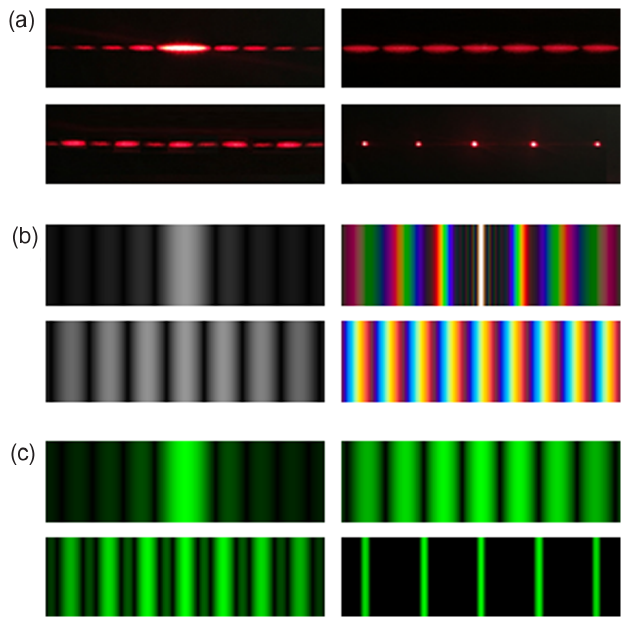
FIG. 1. (a) Red laser light patterns obtained by the single slit, double slit, three slits, and diffraction grating were possible answers for question Q1 – Q3. (b) Four patterns were possible answers for question Q4 where students were asked to recognize pattern produced by passing white light through a diffraction grating (gray single-slit pattern, correct pattern, gray double-slit pattern, rainbow fringes). (c) Green light patterns obtained by the single slit, double slit, three slits, and diffraction grating were possible answers for question Q5 –